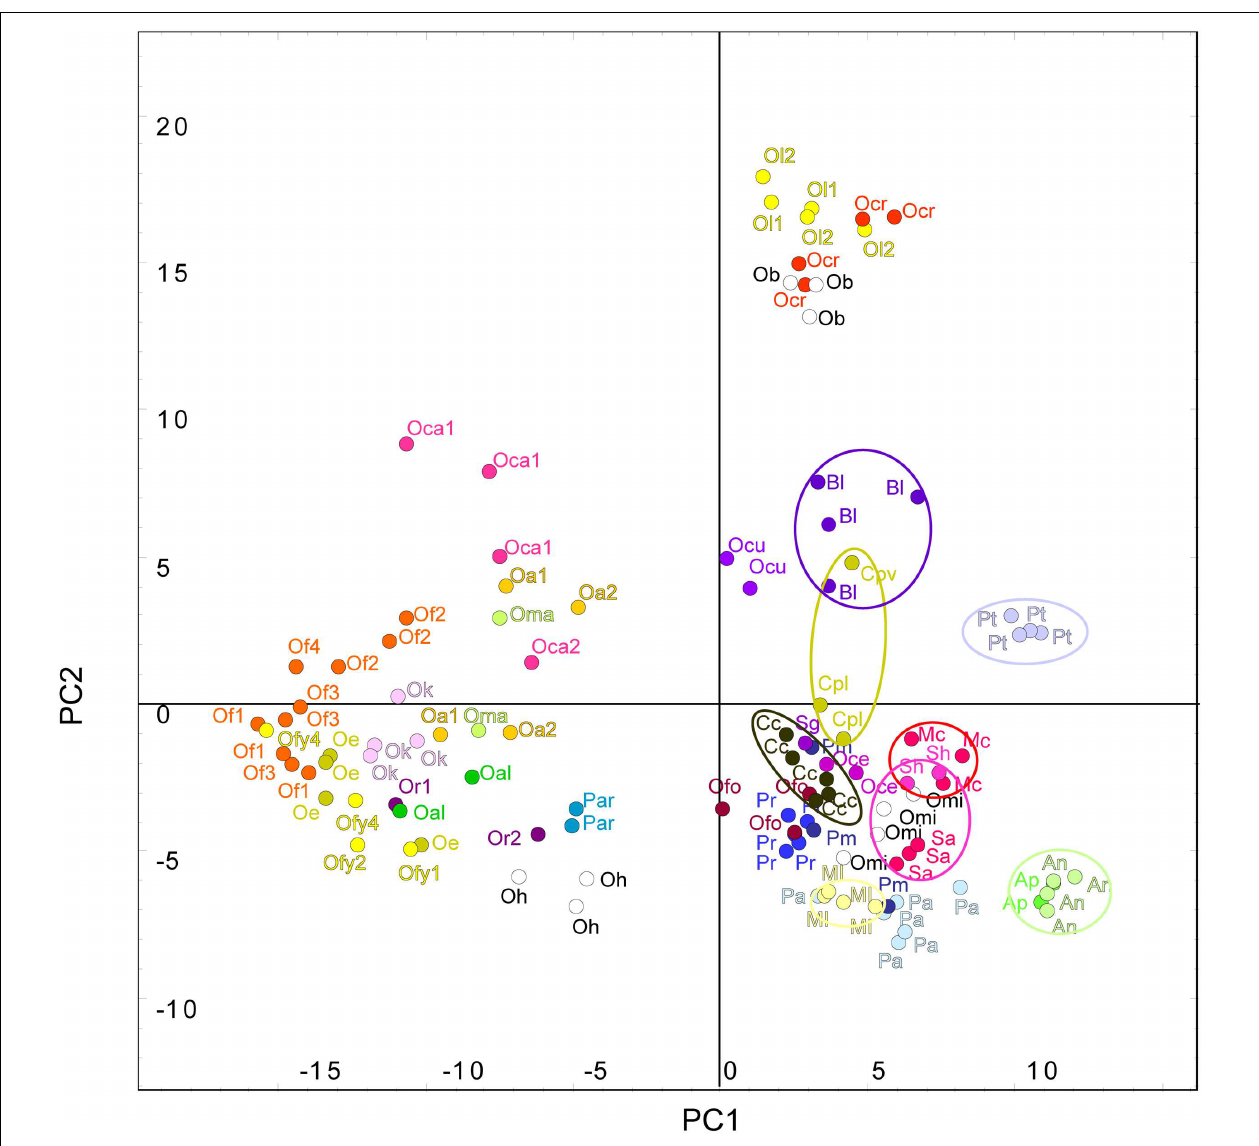
FIGURE 2 | Principal component (PC) analysis of the floral blends of the 32 species studied. Principal component analysis (PCA) was done with compounds showing a significant difference between the species ( P < 0.05 from ANOVA test) and it was performed by GeneMath XT. Letters and symbols represent single species. An , Antirrhinum majus nanum ; Ap , A. majus pumilum ; Bl , Boulardia latisquama ; Cpl , Cistanche phelypea (lutea); Cpv , Ci. phelypea (violacea); Cc , Cynomorium coccineum ; Mc , Mimulus cardinalis ; Ml , M. luteus ; Oa1, Oa2 , Orobanche alba (location 1, 2); Oal , O. alsatica ; Ob , O. ballotae (white color); Oca1, Oca2 , O. caryophylacea (location 1, 2); Oce , O. cernua ; Ocr , O. crenata ; Ocu , O. cumana ; Oe , O. elatior ; Of1–Of4 , O. flava (location 1,2,3,4), Ofy1,2,4 , O. flava yellow morph (location 1,2,4); Ofo , O. foetida ; Oh , O. hederae (white color); Ok , O. kochii ; Ol1, Ol2 , lutea (year 1,2); Oma , O. mayeri ; Omi , O. minor (white color); Or1, Or2s , O. reticulata (location 1,2); Pa , Phelipanche aegyptiaca ; Par , Ph. arenaria ; Pm , Ph. mutelii ; Pr , Ph. ramosa ; Pt , Paulownia tomentosa ; Sa , Striga asiatica ; Sg , S. gesnerioides ; Sh , S. hermonthica